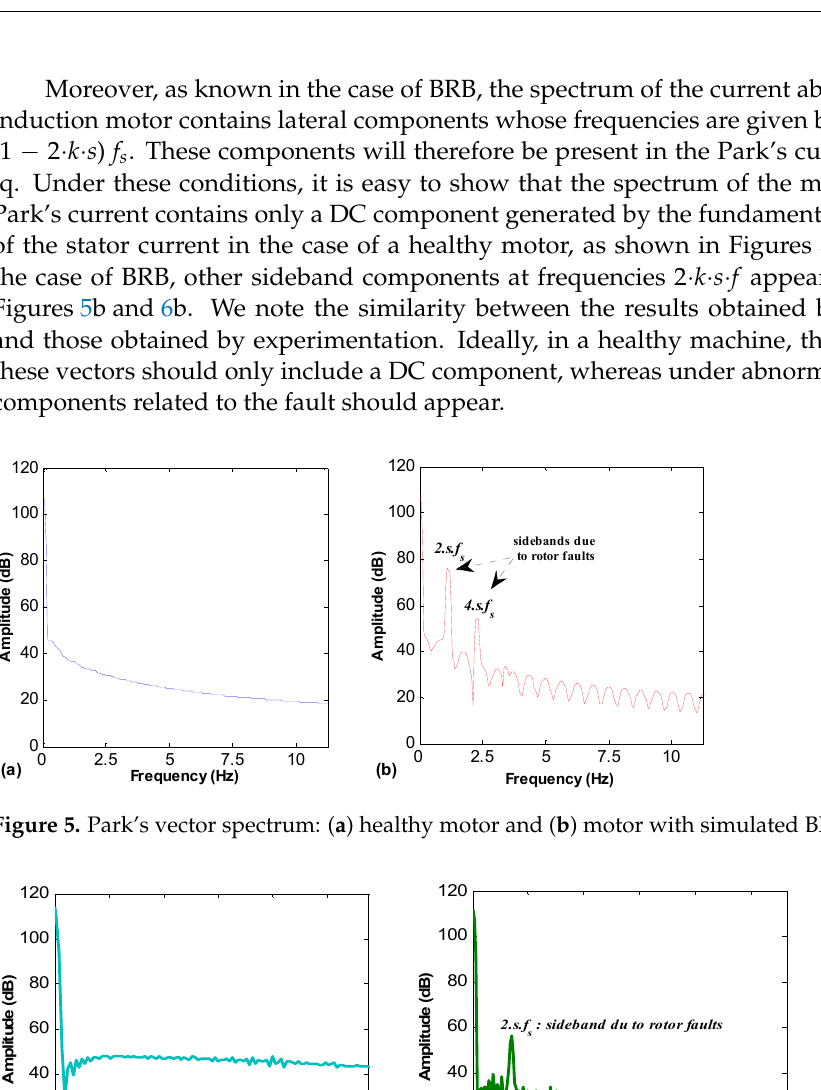
Figure 4. Park’s vector trajectories: ( a ) healthy motor and ( b ) motor with one BRB (experimental result).